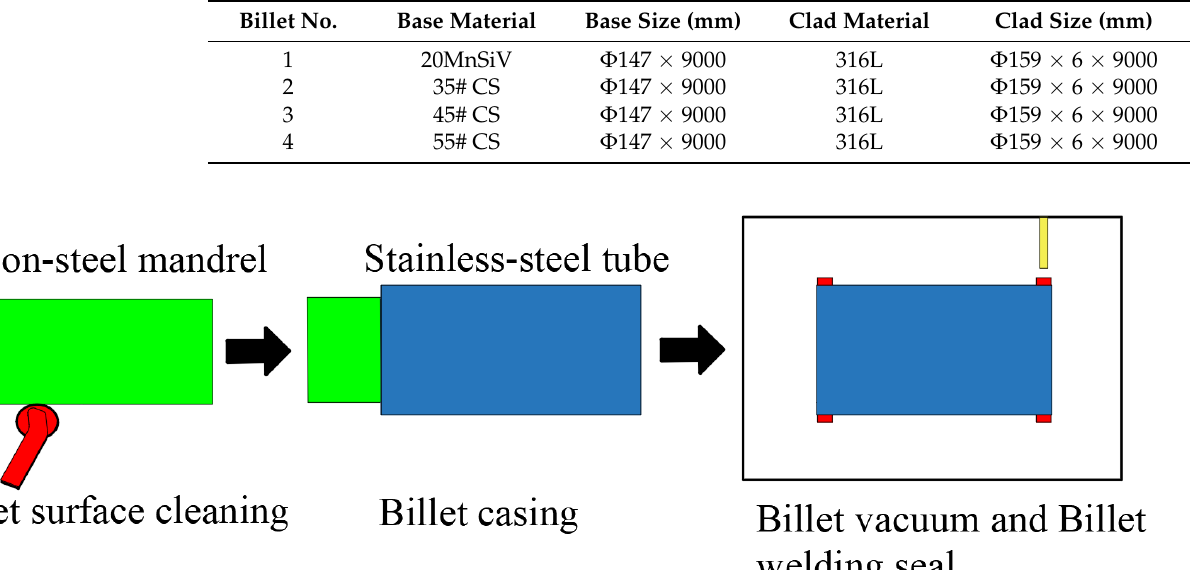
Figure 3. Rolling pathway of the clad rebar. 2.3. Detection Method The end surfaces of the clad rebar were photographed with an RAL 2048-48GM in- dustrial camera (Basler, Arensburg, Holstein, Germany), and then the images were im- ported into the CAD 2013 (Autodesk company, San Rafael, CA, USA) software for cali- bration. Finally, the average value, range, and variance of the rebar cladding thickness were calculated based on Figure 4 and Formulas (1)–(3).